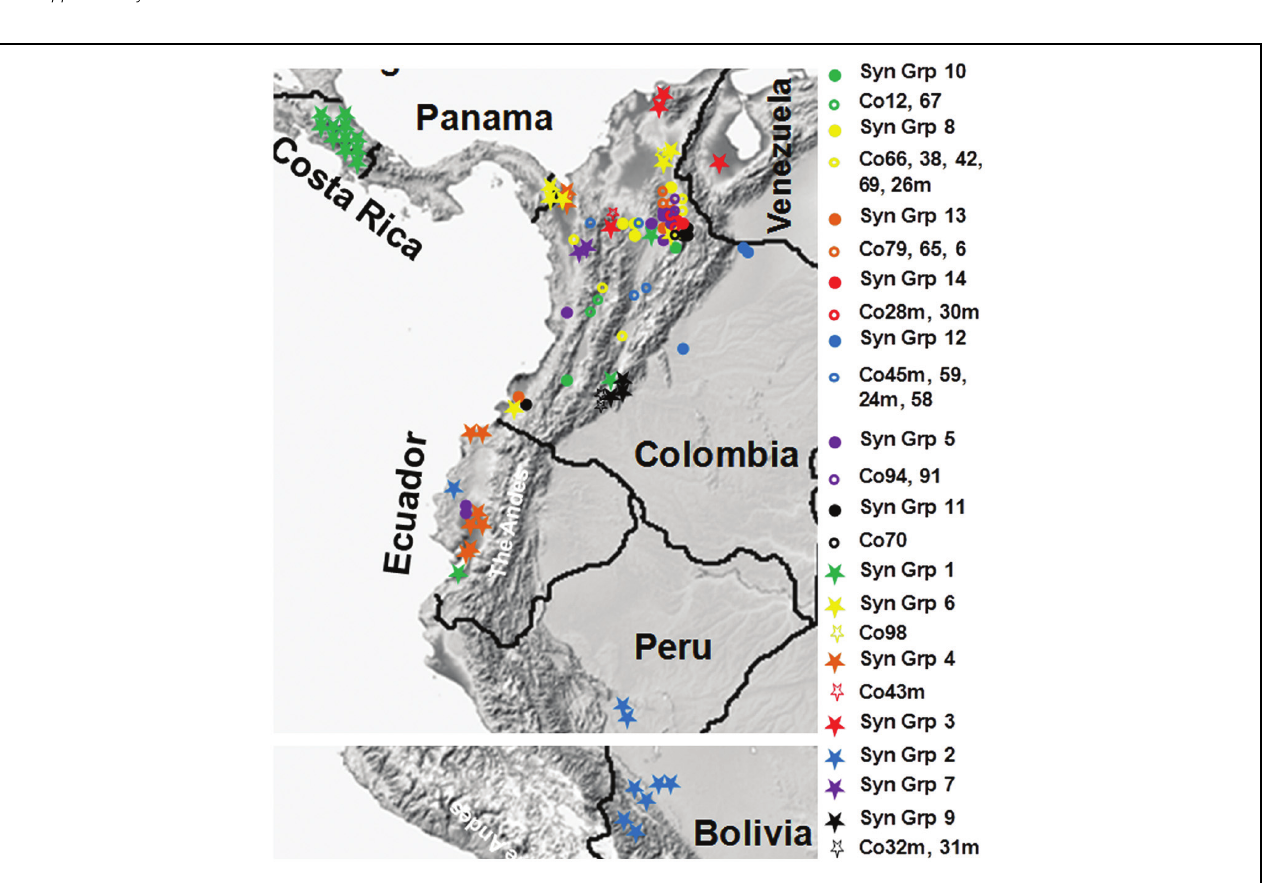
FIGURE 4 | Geographical distributions of M. roreri isolates collected from frosty pod rot affected areas of South and Central America and their phylogenetic relation. Isolates were collected from infected cacao pods from 1999 to 2013. Approximate